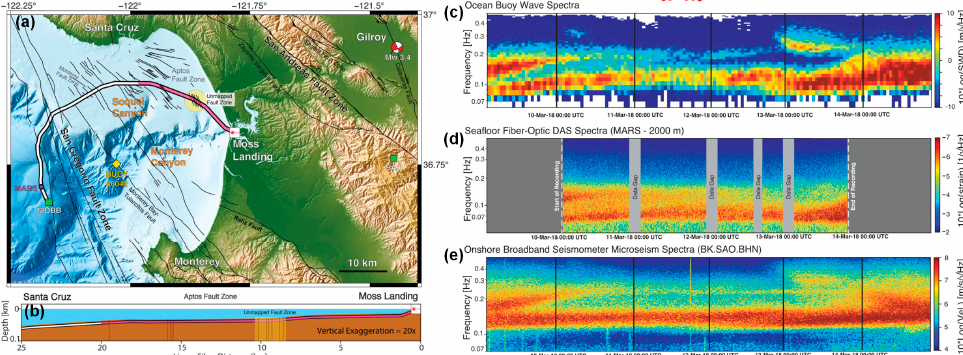
Figure 21. ( a ) Map of Monterey Bay, CA, showing the Monterey Accelerated Research System (MARS) cable (DAS, pink portion), mapped faults, the Gilroy earthquake (red and white beach ball), and major bathymetric features. ( b ) Cross ‐ section illustration of the MARS cable used for DAS. ( c ) The 10 min average wave height and spectral wave density (SWD) measurements outside Monterey Bay, which were measured using a buoy. ( d ) Seafloor DAS strain from a 2 km cable location averaged over a 15 min sliding window. ( e ) North component of ground velocity from an onshore broadband inertial seismometer averaged over a 15 min sliding window [86].